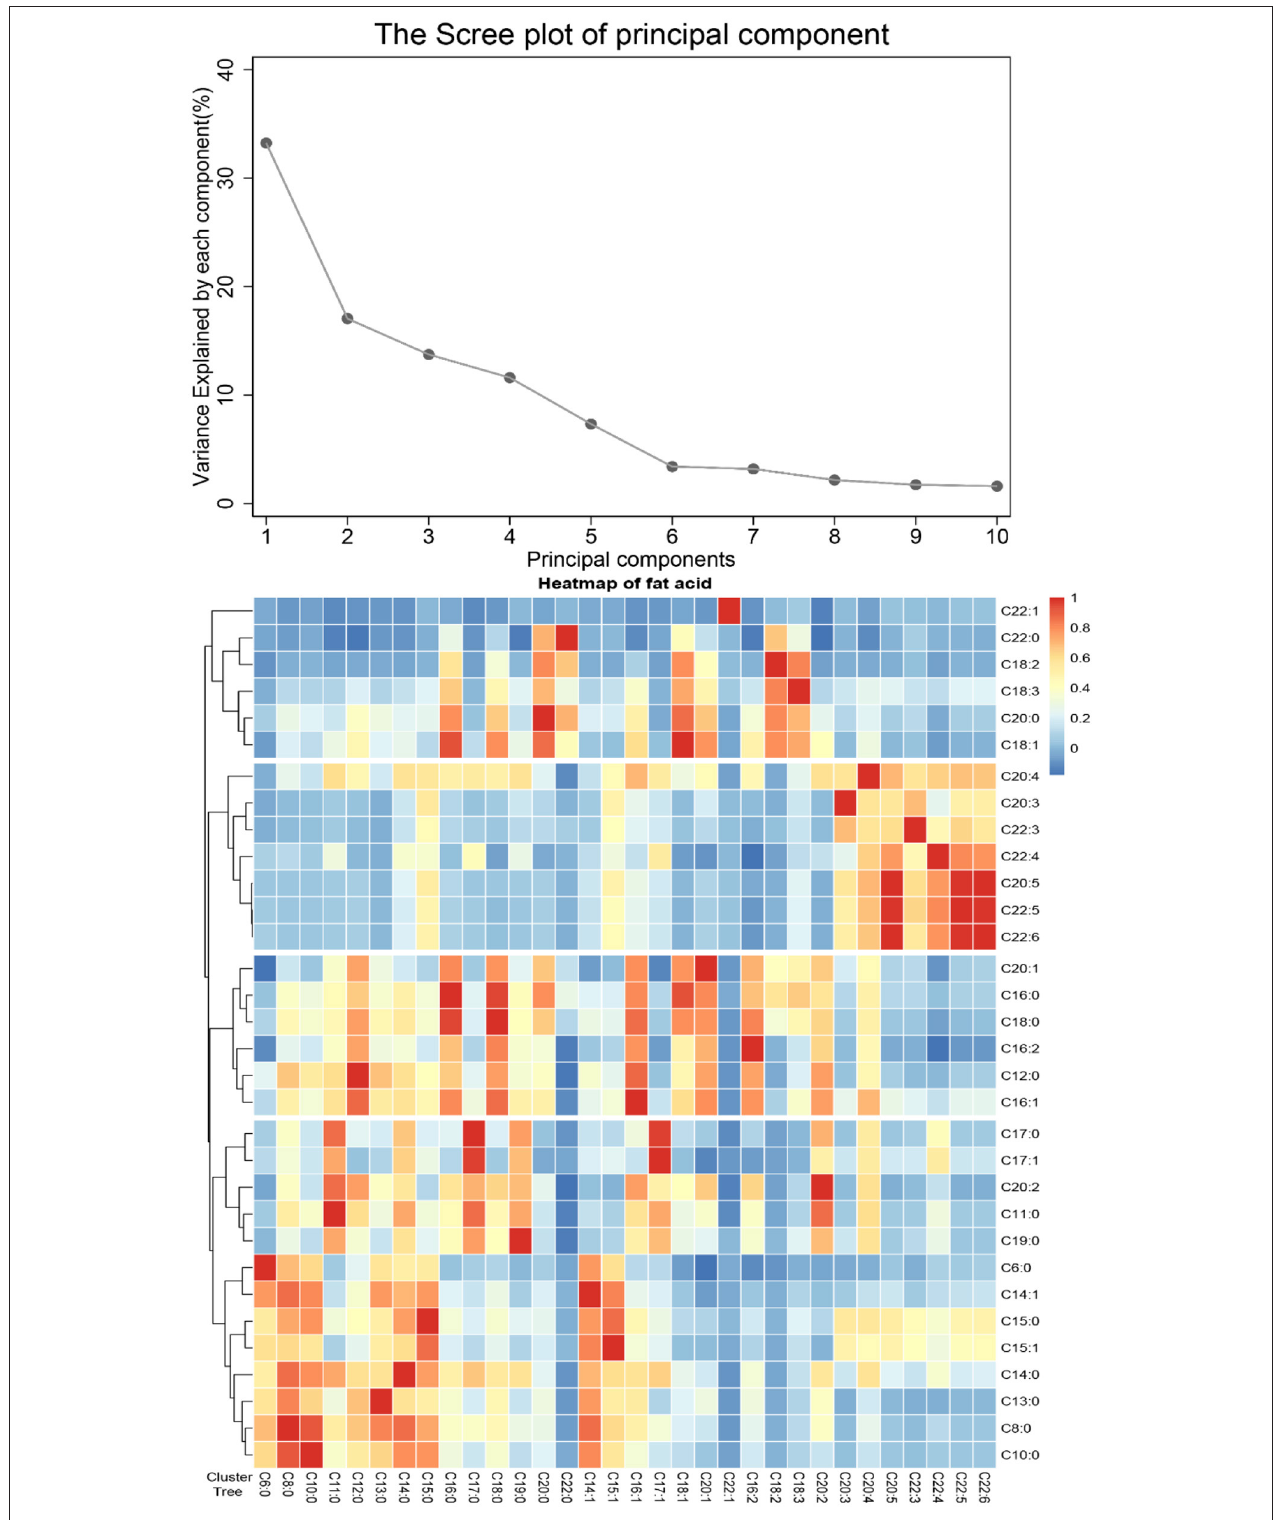
FIGURE 1 | Principal components and clusters of 32 fatty acids. (A) The proportion of total variance of 32 fatty acids explained by each principal component. (B) Association among 32 fatty acids, the hierarchical cluster tree on the left, and the heatmap of fatty acid on the right.